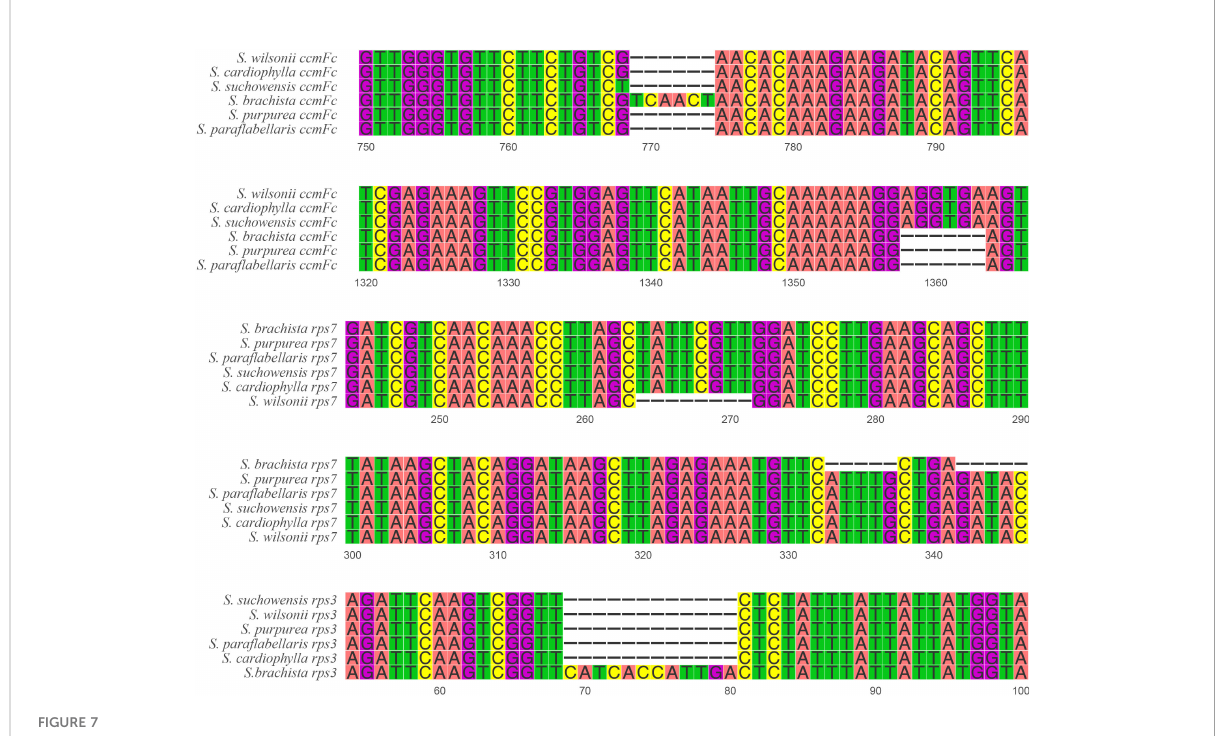
FIGURE 7 InDel distribution of PCGs in six Salix